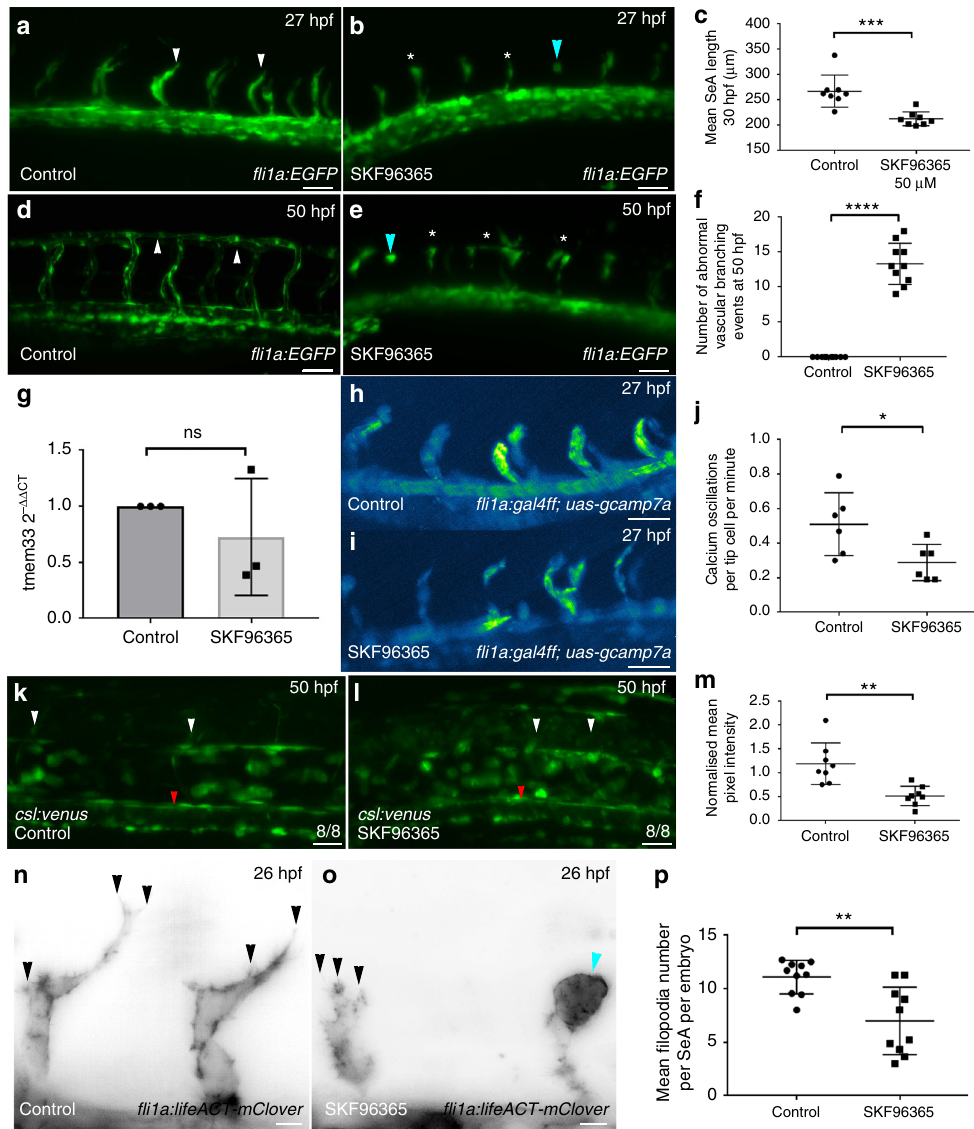
Fig. 7 SOCE inhibition limits sprouting angiogenesis and disrupts signalling pathways downstream of VEGF. a , b SKF9635 impairs angiogenesis in Tg( fl i1a: EGFP) embryos (white arrowheads) and induces abnormal tip cell morphology (blue arrowhead) by 27 hpf. Scale bars 50 µ m. c SKF-96365-treated embryos display reduced SeA length by 27 hpf (unpaired t -test; p = < 0.0001; t = 11.22 DF = 14; 2 repeats, n = 4 embryos per group). d , e SKF-96365 treatment impairs DLAV formation (white asterisks) in comparison with control embryos, which form the DLAV normally by 50 hpf (white arrowheads). Abnormal tip cell morphology (blue arrowhead) remain in SKF-96365-treated embryos by 50 hpf. Scale bars 50 µ m. f SKF-96365-treated embryos display increased frequency of abnormal vascular branching (stunted SeAs or incomplete DLAV anastomosis) by 50 hpf (unpaired t -test; p = < 0.0001; t = 14.28 DF = 18. n = 2 repeats, n = 5 embryos per group). g tmem33 expression is not signi fi cantly altered by SKF-96365 treatment (unpaired t -test; t = 0.911, DF = 4, n = 3 repeats). h – j SKF-96365 reduces frequency of endothelial Ca 2 + oscillations in Tg( fl i1a:gal4FF ubs3 ;uas-gcamp7a) embryos. Intensity projection over time showing calcium oscillations in control embryos, highlighting intensity change over duration of time lapse (unpaired t -test; p = < 0.05; t = 2.594, DF = 10, n = 2 repeats, 3 embryos per group). k , l Notch reporter expression is reduced in SeAs (white arrowheads) and DA (red arrowhead) of Tg(csl: venus) embryos. Scale bars 50 µ m. m DA expression of Notch reporter is reduced by SKF treatment (unpaired t -test, ** p = 0.0097, t = 3.982 DF = 15, 2 repeats, n = 4 embryos per group). n , o SKF-96365 treatment reduces endothelial fi lopodia number (black arrowheads) and abnormal spade-shaped tip cell morphology (blue arrowhead), in Tg( fl i1a:lifeact-mClover) embryos. Scale bars 5 µ m. p SKF-96365 treatment reduces mean fi lopodia number per SeA per embryo by 26 hpf (unpaired t -test; p = < 0.05; t = 2.525, DF = 10, n = 2 repeats, n = 5 embryos per group). Source data are provided as a Source Data